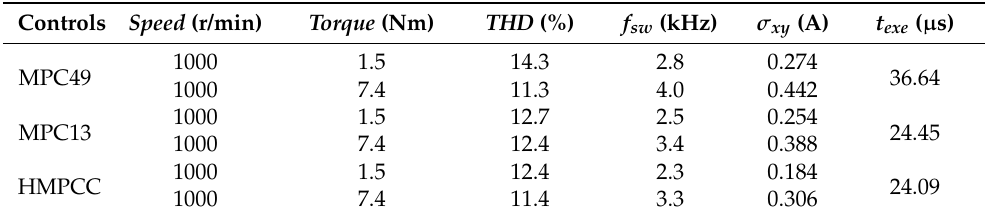
Table A3. Summary of the performance indicators for the control strategies applied to the asymmet- rical six-phase IM (Test 3).